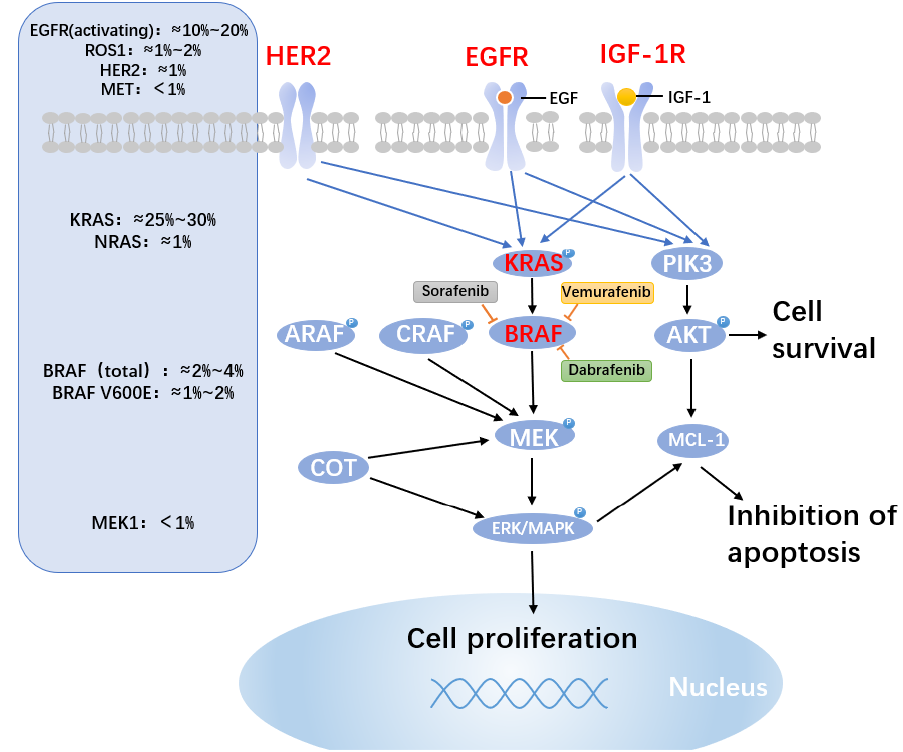
Figure 3. BRAF medication resistance mechanisms and mutation probability. BRAF mutations resulted in altered mitogen-activated protein kinase (MAPK) molecules. The approximate frequencies of frequent driver mutations discovered in the MAPK pathway in lung cancer are shown on the left side of the figure. BRAF valence at codon 600 (V600E) mutations, which cause native activation of BRAF, is only found in 1–2% of lung cancers. In patients with activating BRAF mutations, clinical study of BRAF alone or in combination with downstream MEK inhibition is continuing. On the right, prominent BRAF inhibitors are described. BRAF inhibitor resistance is conferred through cRAF, ARAF, the MAP kinase family member COT, and the pro-survival members of the BCL-2 family MCL-1. Despite BRAF inhibition, increased production of the alternative RAF isoforms (ARAP and CRAF) and MAP3K8/COT can still activate the MAPK pathway. The PI3K and MAPK pathways, which may offer paths around BRAF inhibition and apoptosis, also activate MCL-1.